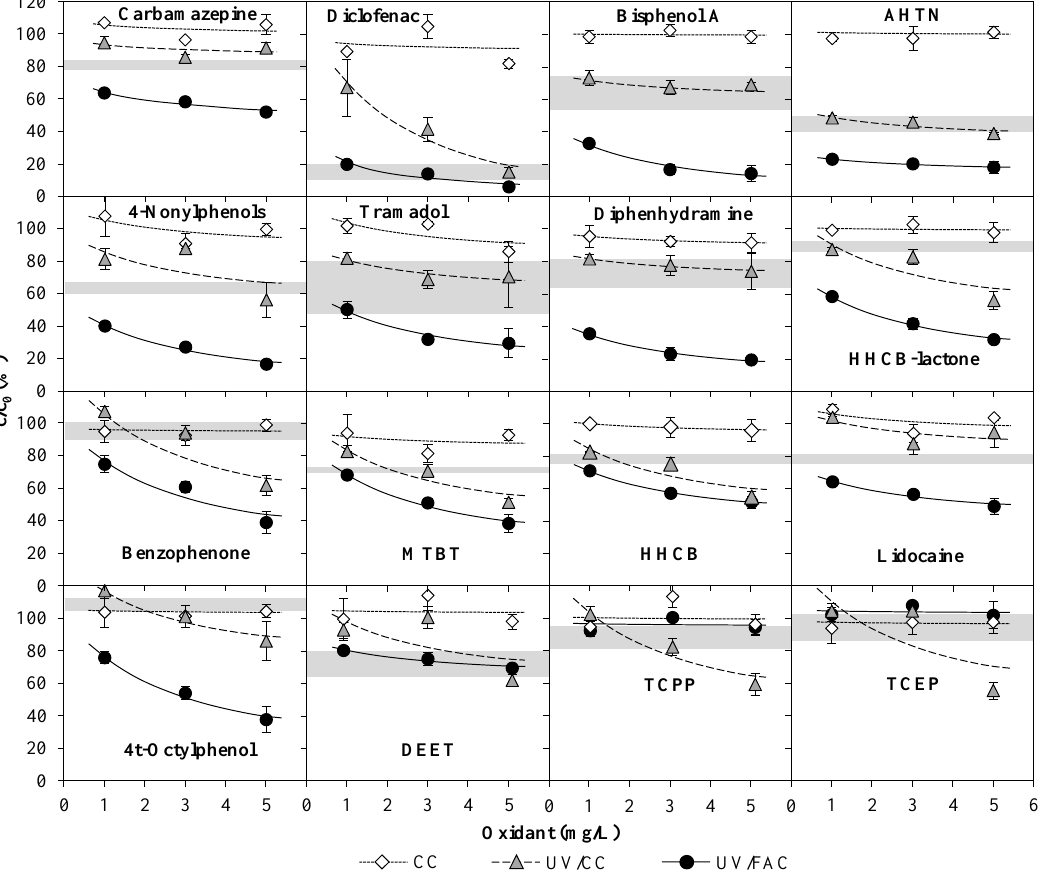
Figure 9. Emerging contaminants found in WWTE after treatment with the UV/FAC AOP [7], the UV/CC AOP (Exp. C) at 0.4 kWh/m 3 electrical energy consumption (0.4 kW) and with CC alone (no UV, Exp. C) as a function of the oxidant concentration (1 m 3 /h flow rate). Gray line: sole UV treatment at 0.4 kWh/m 3 (1 m 3 /h flow rate) [7]. For E EO values, see Table S7.